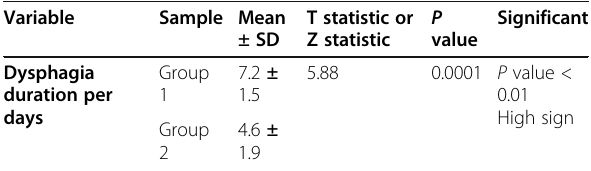
Table 4 The distribution of dysphagia post-operatively Variable